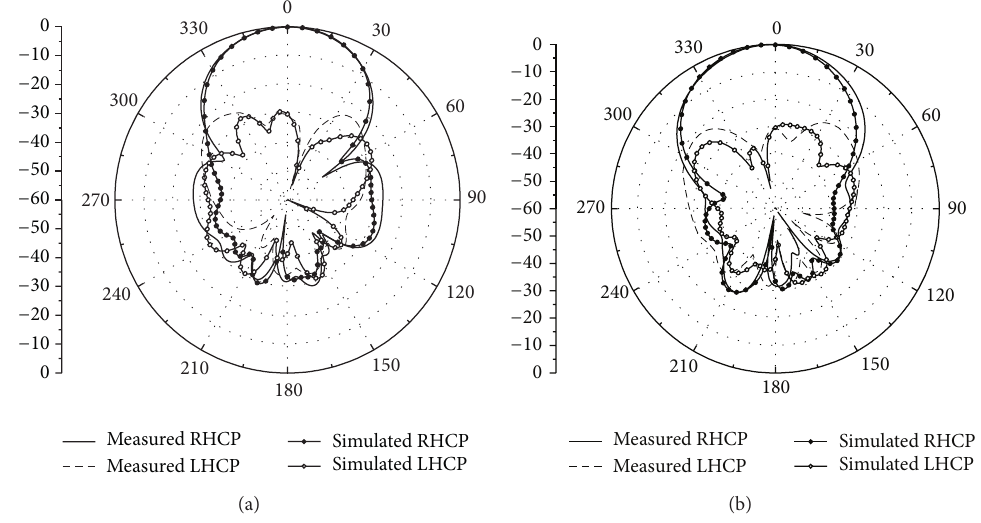
Figure 9: Measured and simulated radiation patterns at 10.3 GHz (a) 𝑥𝑜𝑧 plane and (b) 𝑦𝑜𝑧 plane.